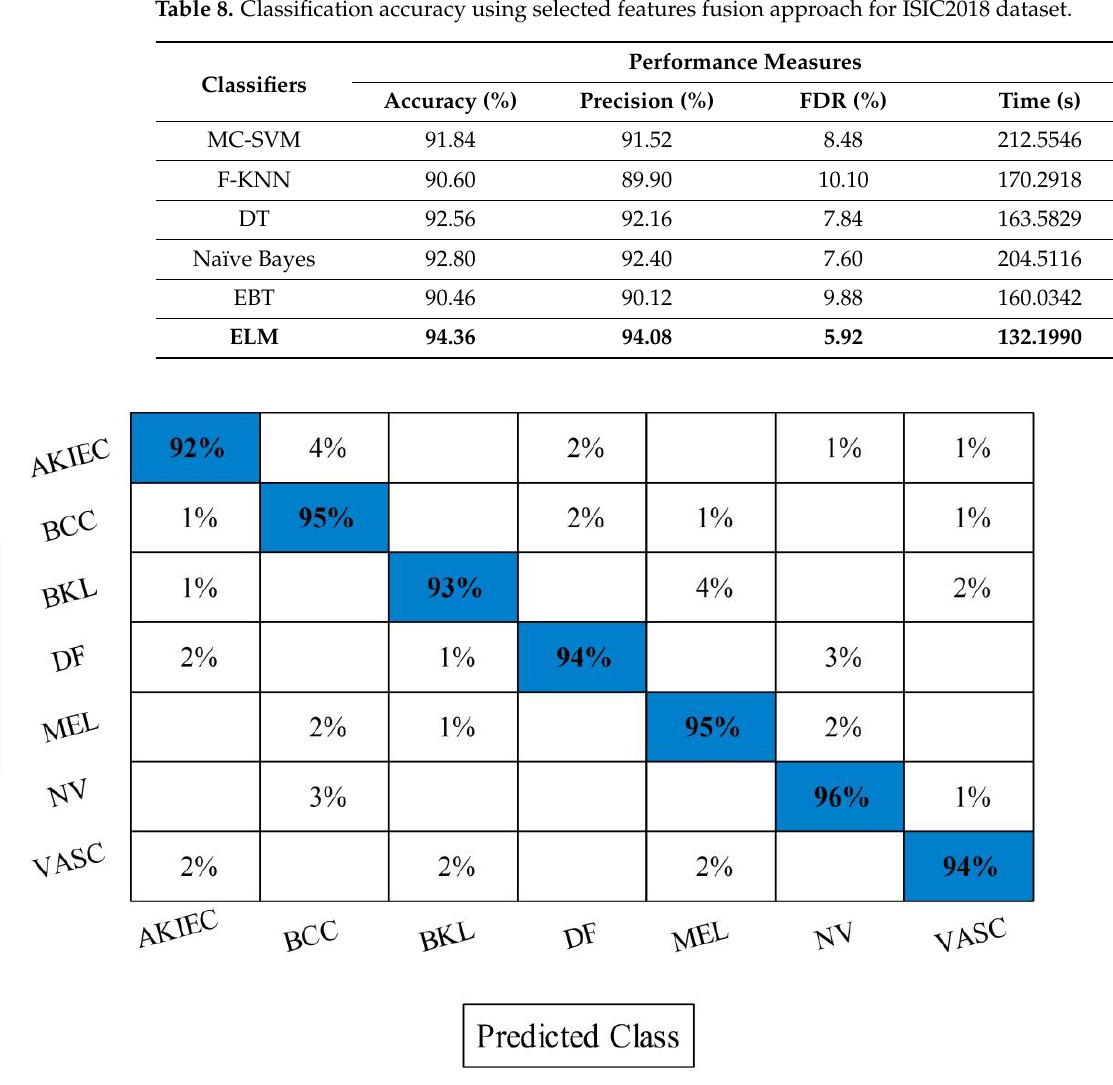
Figure 12. Computational time based comparison among middle steps for ISIC2018 dataset.